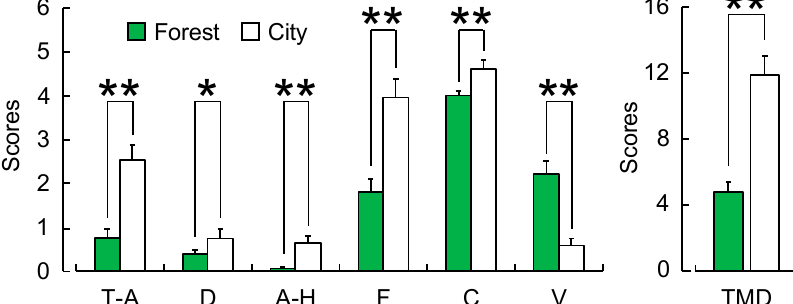
Figure 6. The participants’ subjective feelings as measured by the six subscales and the total mood disturbance (TMD) score of the Profile of Mood States questionnaire after viewing forest and city areas. Data are shown as means ± standard error ( n = 65). ** p < 0.01, * p < 0.05, Wilcoxon signed-rank test (one-sided). T–A, tension and anxiety; D, depression and dejection; A–H, anger and hostility; F, fatigue; C, confusion; V,